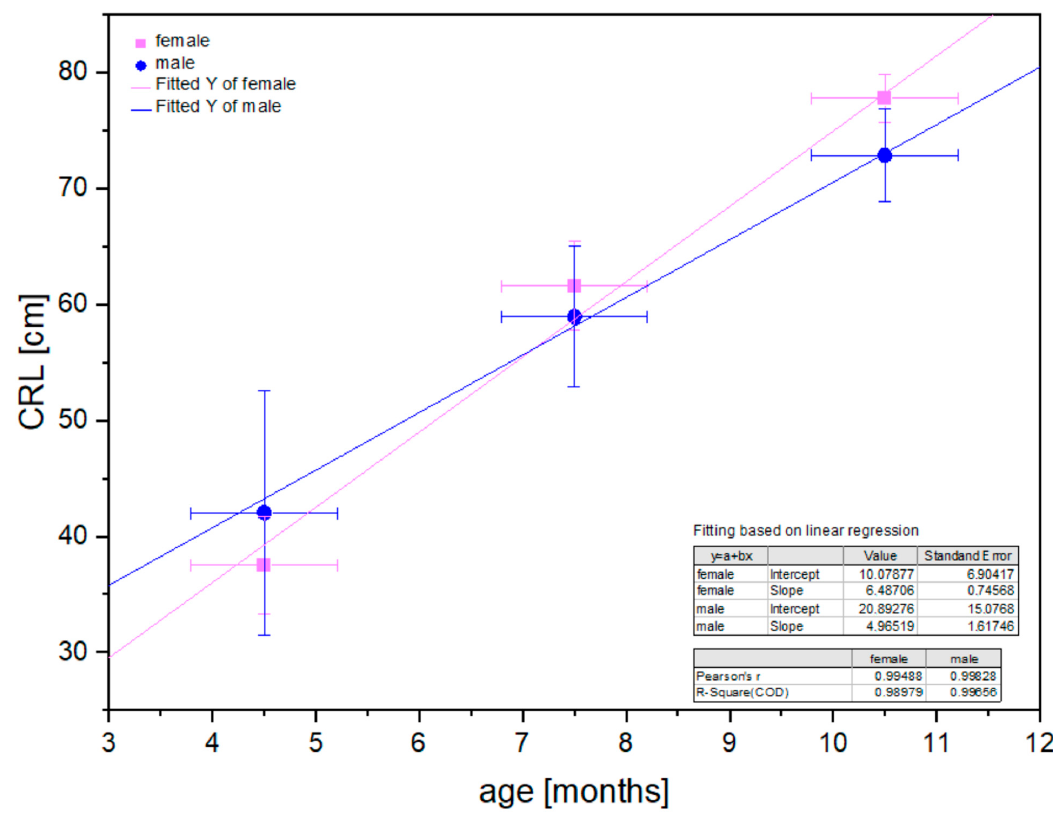
Figure 2. Linear regression in CRL values in the fetal period for male and female horse fetuses. 3.2. Anatomy and Topography of the Stomach (Holotopy, Skeletotopy, Syntopy)